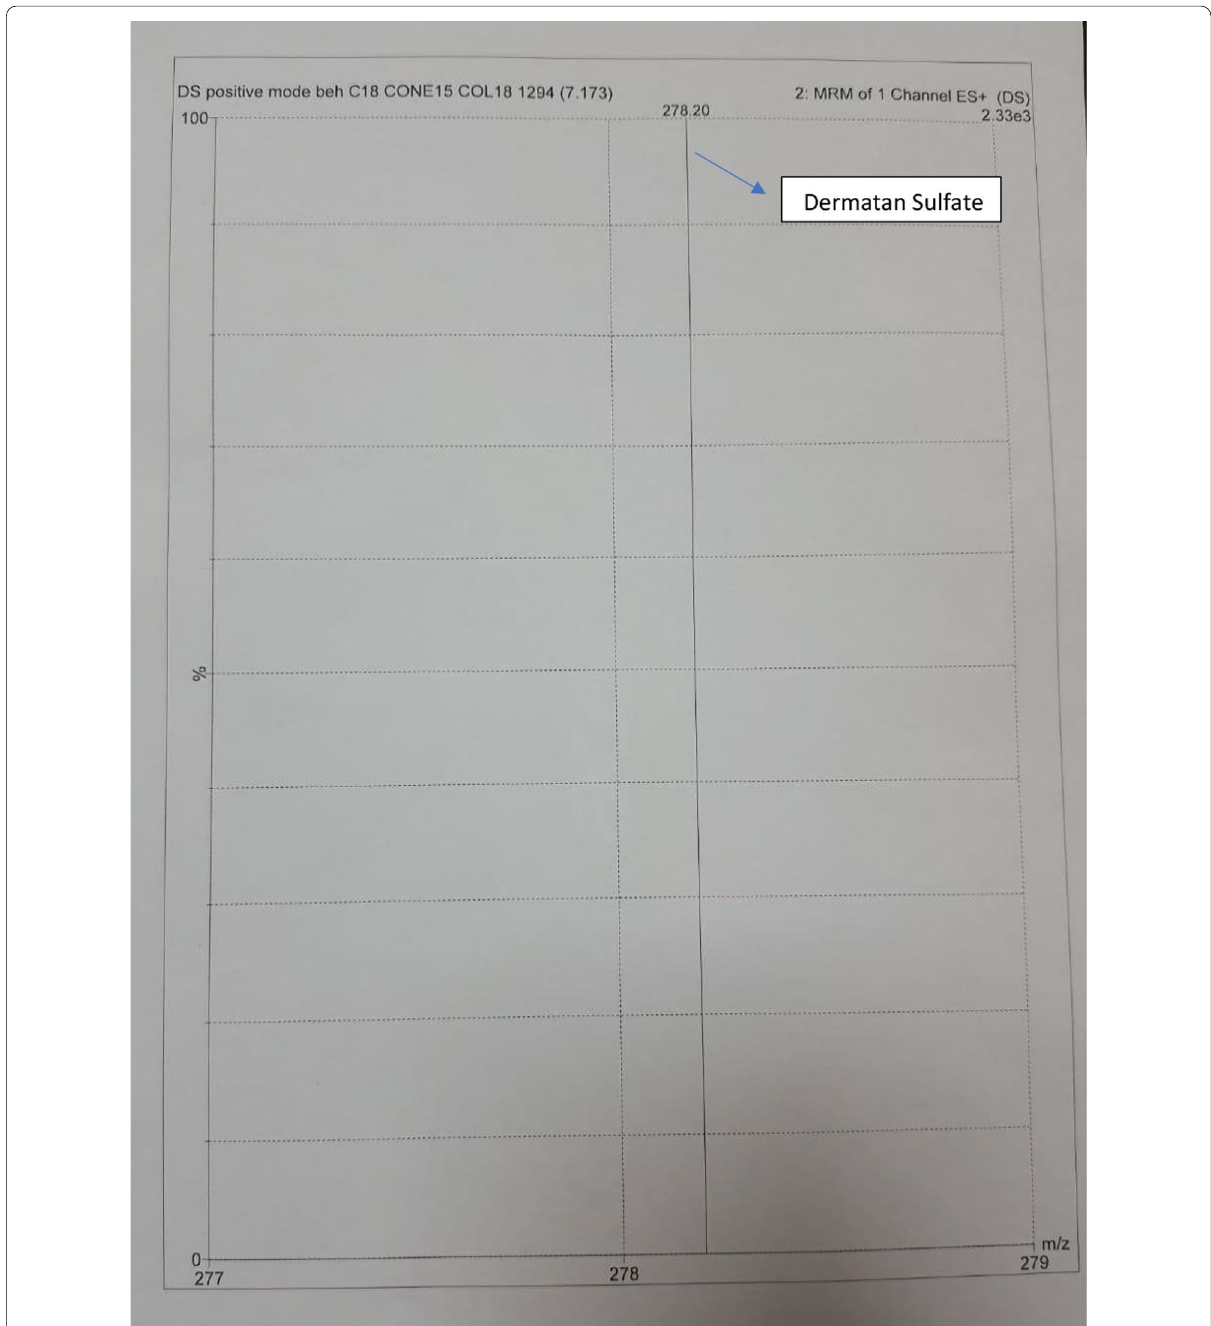
Fig. 2 Chromatogram of Dermatan Sulfate by Mass Spectrometry showing daughter fragment release from DS by butanolysis in positive